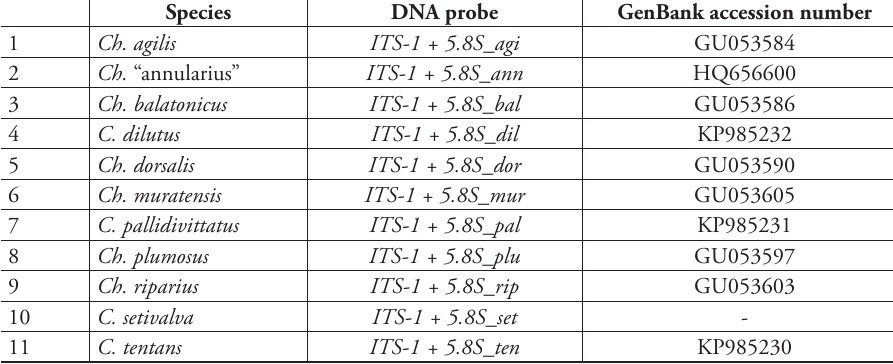
Table 1. The DNA probes used in the work. Species DNA probe GenBank accession number